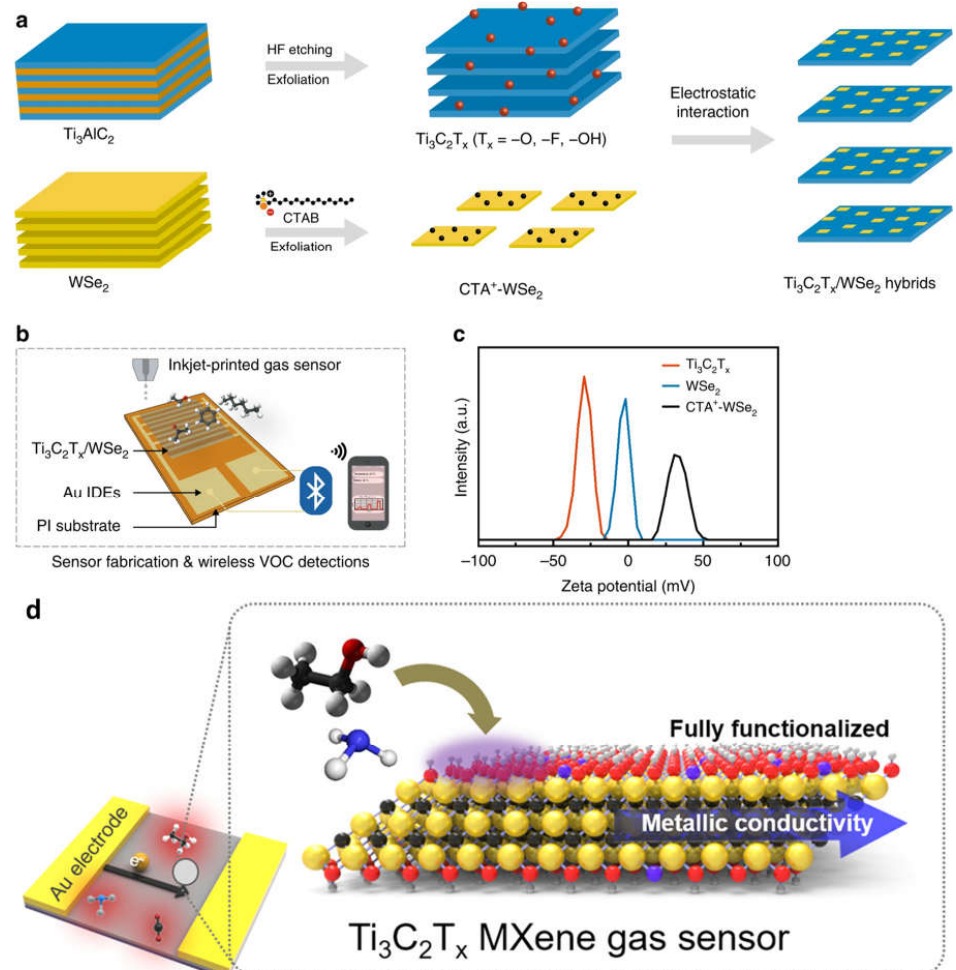
Figure 4. ( a ) Illustration of a schematic of the nanohybrids of Ti 3 C 2 T x and WSe 2 ; ( b ) a diagram depiction of inkjet-printed gas sensors used in a wireless monitoring system for detecting volatile organic compounds; ( c ) distributions of the zeta potential for the CTA + -WSe 2 dispersions, WSe 2 , Ti 3 C 2 Tx; ( d ) diagrammatic illustration of the Ti 3 C 2 T x films, its atomic structure. Reproduced with permission from references [49,53].